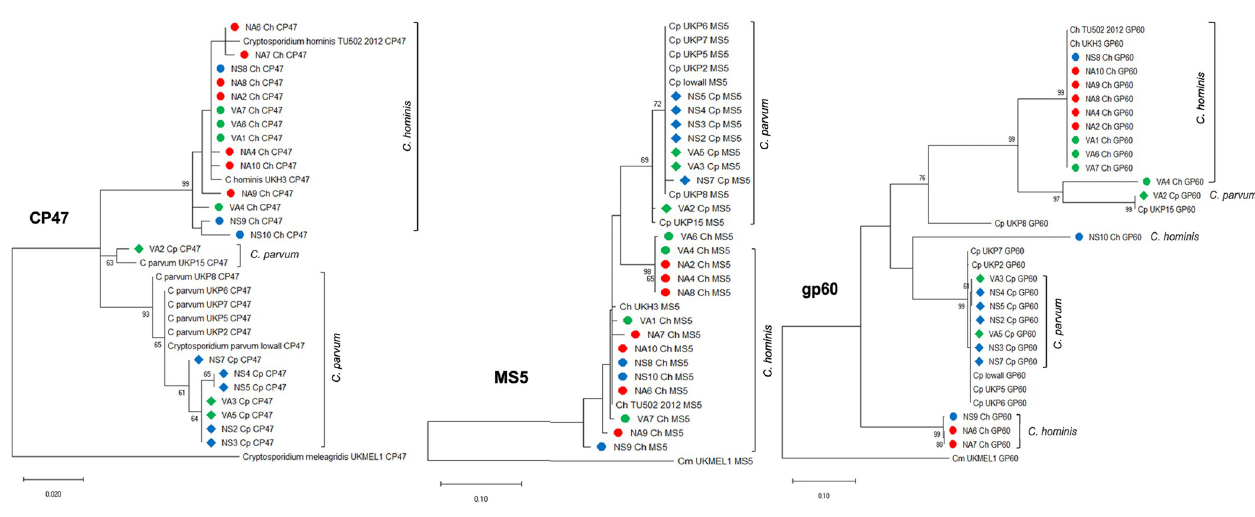
Fig 4. Phylogenetic trees constructed with the sequences of CP47 , gp60 , MS5 markers genes.